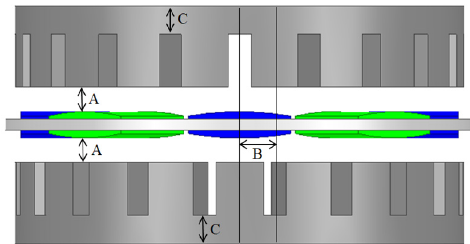
Figure 10. Symmetrical position of the generator. Table 3. Control factors and levels of FP-AFPMG.